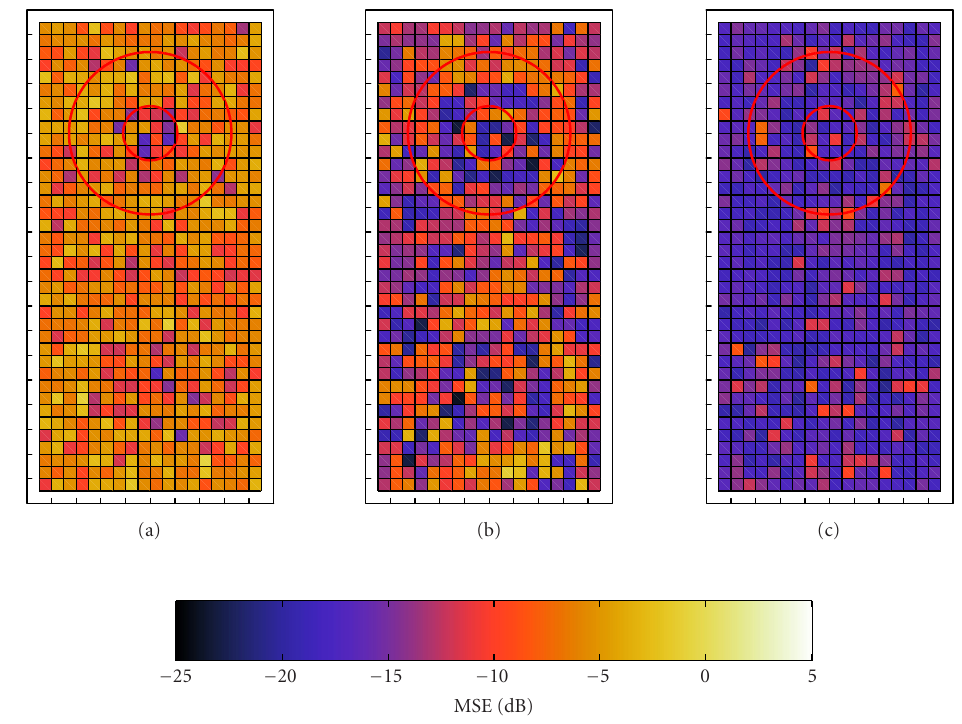
Figure 11: Average MSE of 32 subcarriers, averaged over 500 OFDM symbols, with 4-QAM modulation. A microstrip antenna pattern was applied, as compared to previous simulation cases using omnidirectional antennas. The small (5 pixels wide) circle corresponds to the base unit being at 60 degrees, while the large (13 pixels wide) circle corresponds to the base unit being at 30 degrees, in elevation with respect to the mobile unit. (a) 1 element M = 6. (b) Fixed beamformer M = 6. (c) Adaptive beamformer M =